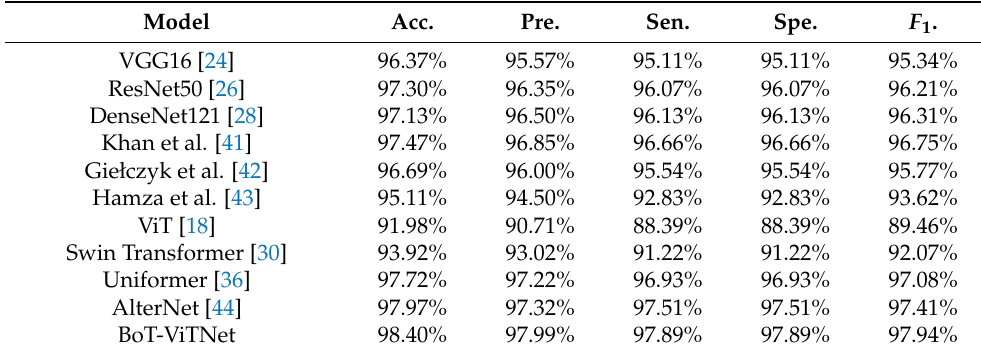
Table 6. The classification results of different models on the Coronahack dataset. Model Acc. Pre. Sen. Spe. F 1